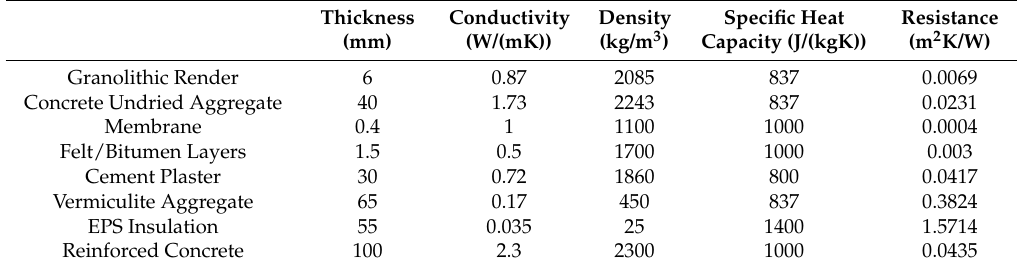
Table 3. Details of RC roof design in